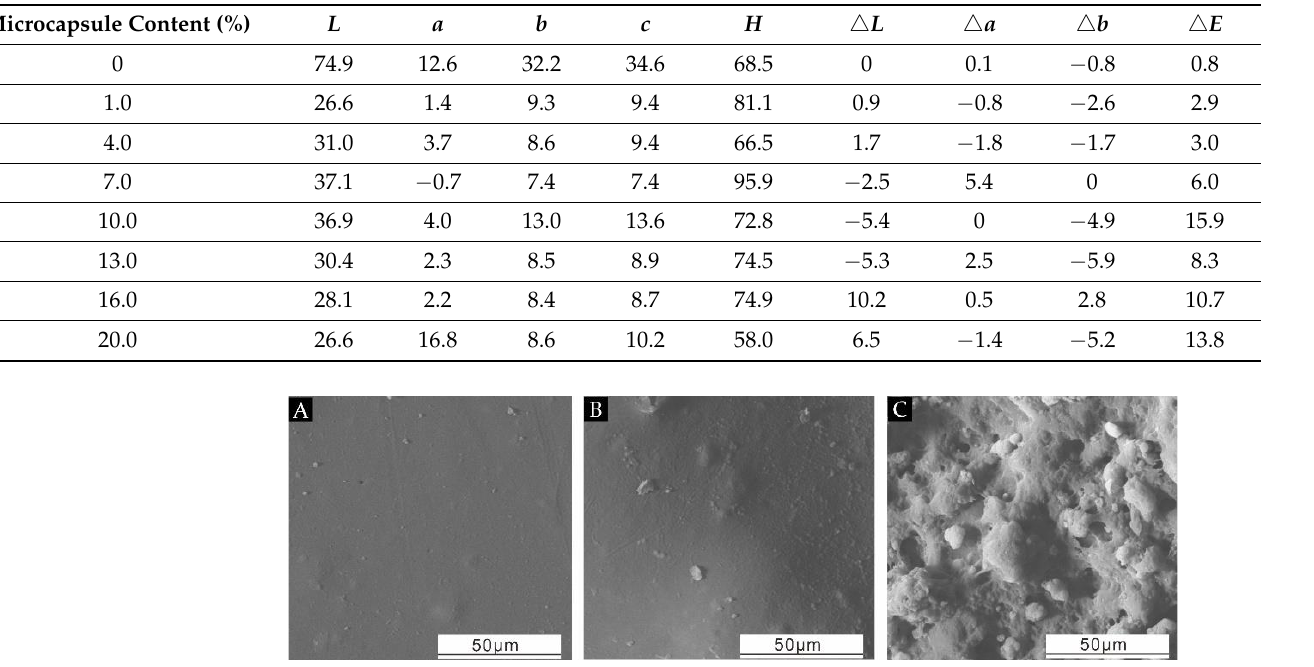
Table 9. Color values of the coatings with core-wall ratio of 0.83.